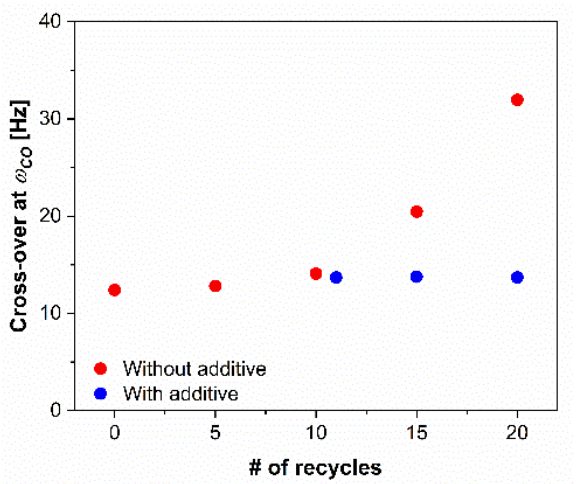
Figure 6. Crossover frequency, ω co , of virgin PP, and recycled PP without and with additive, depending on the processing cycle.